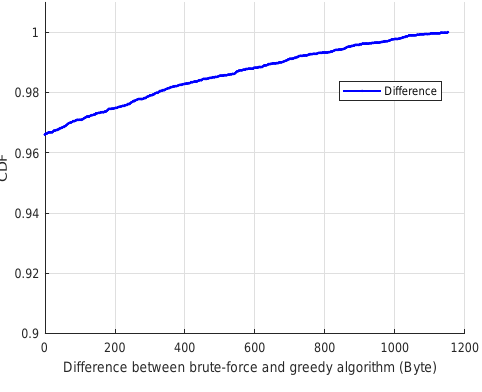
Figure 3. Difference vs. CDF.